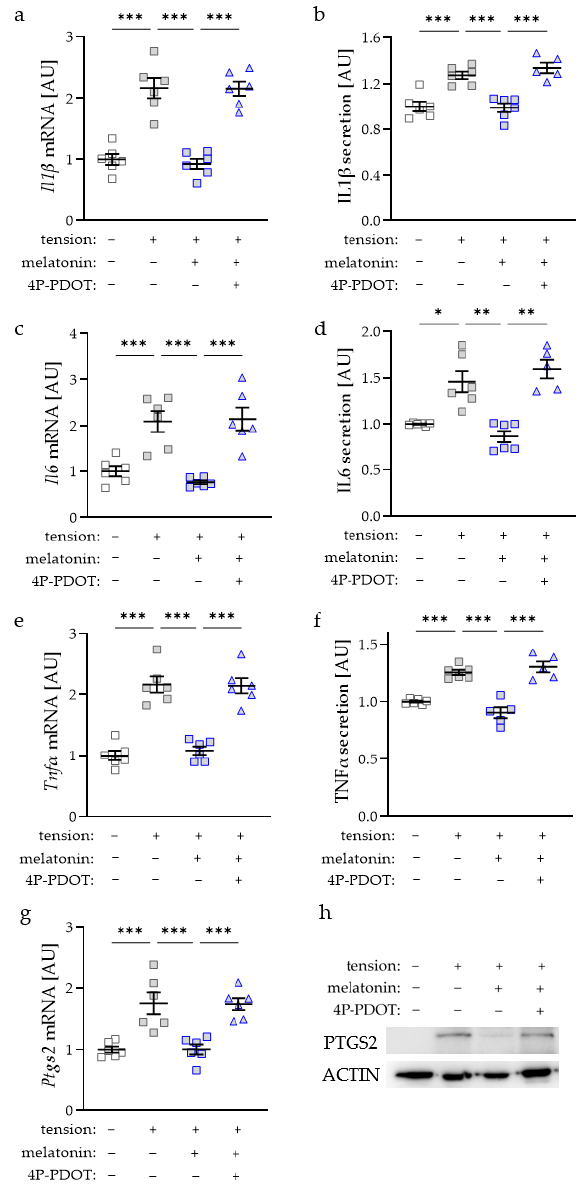
Figure 2. Impact of melatonin and tensile strain on gene and protein expression of interleukin-1-beta (IL1 β ; a , b ), IL6 ( c , d ), tumor necrosis factor alpha (TNF α , e , f ), or prostaglandin endoperoxide synthase-2 (PTGS2, g , h ) in macrophages; uncropped blot is presented in Figure S1. n ≥ 5; Statistics: ordinary ANOVA with Holm – Šídák’s multiple comparison tests expect IL6 secretion (Welch-corrected ANOVA with Games – Howell multiple comparison tests); * p < 0.05, ** p < 0.01, *** p < 0.001. Compressive